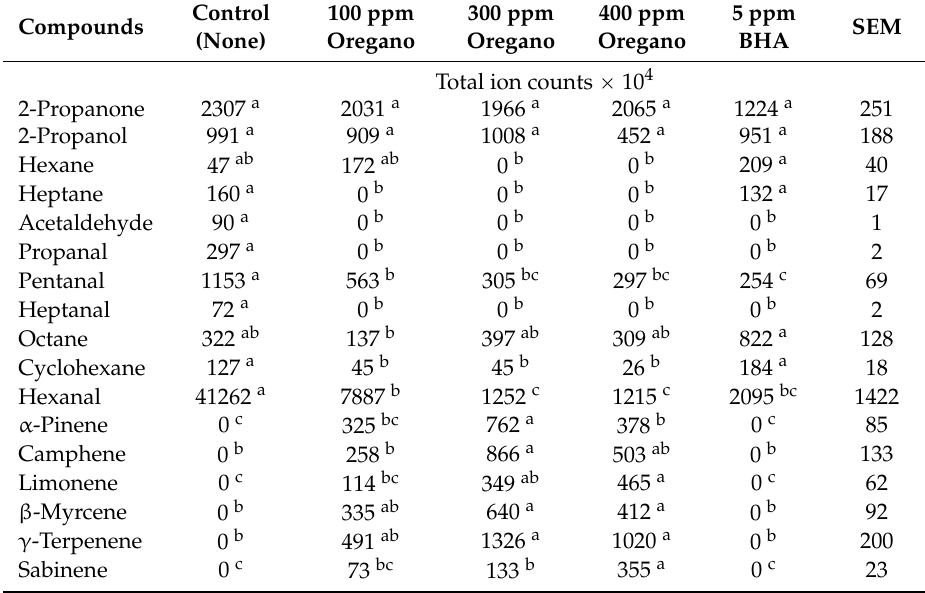
Table 6. Profile of volatiles from cooked chicken breast meat with different levels of oregano oil at day